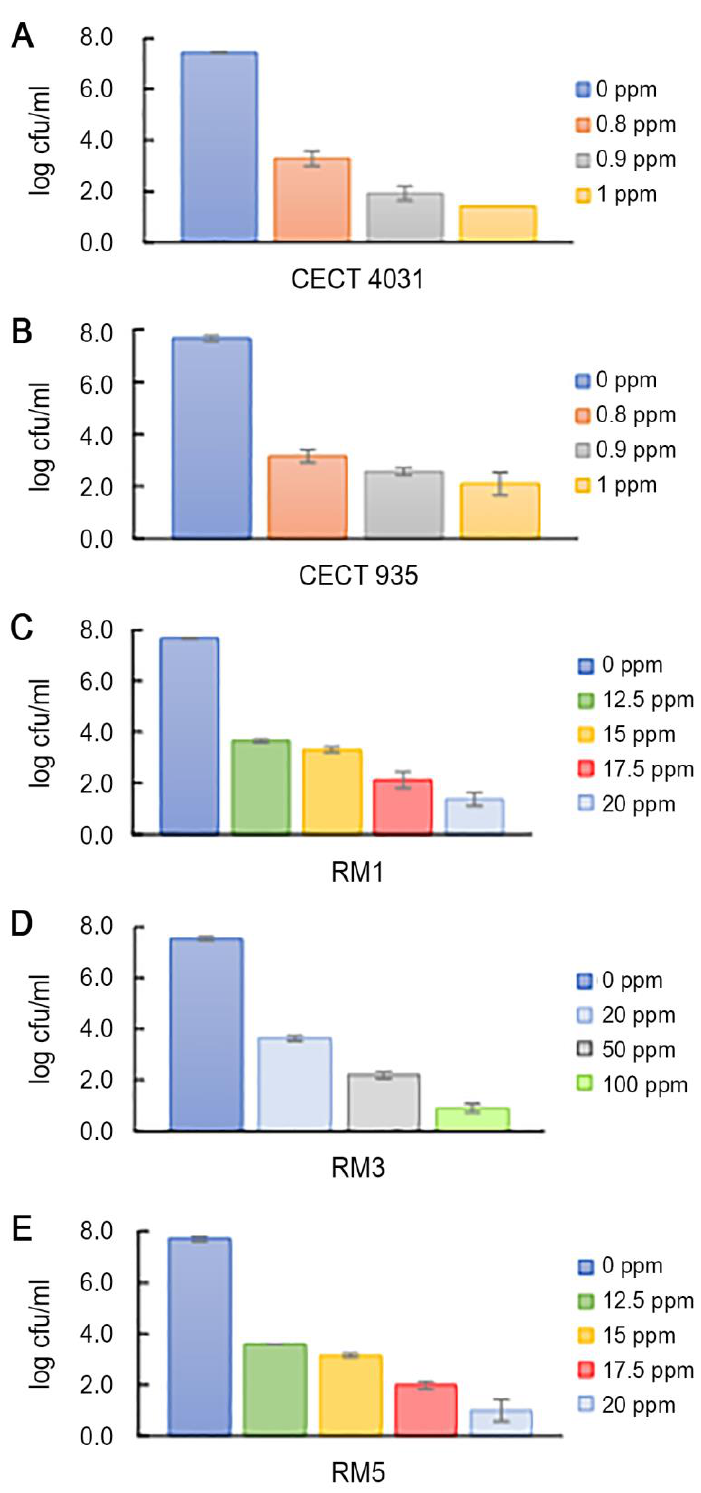
Figure 3. Viable cell counts average and standard deviation (error bars) of the tested planktonic L. monocytogenes strains after treatment with BaC. ( A ) L. monocytogenes CECT 4031; ( B ) L. monocytogenes CECT 935; ( C ) L. monocytogenes RM1; ( D ) L. monocytogenes RM3; ( E ) L. monocytogenes RM5.